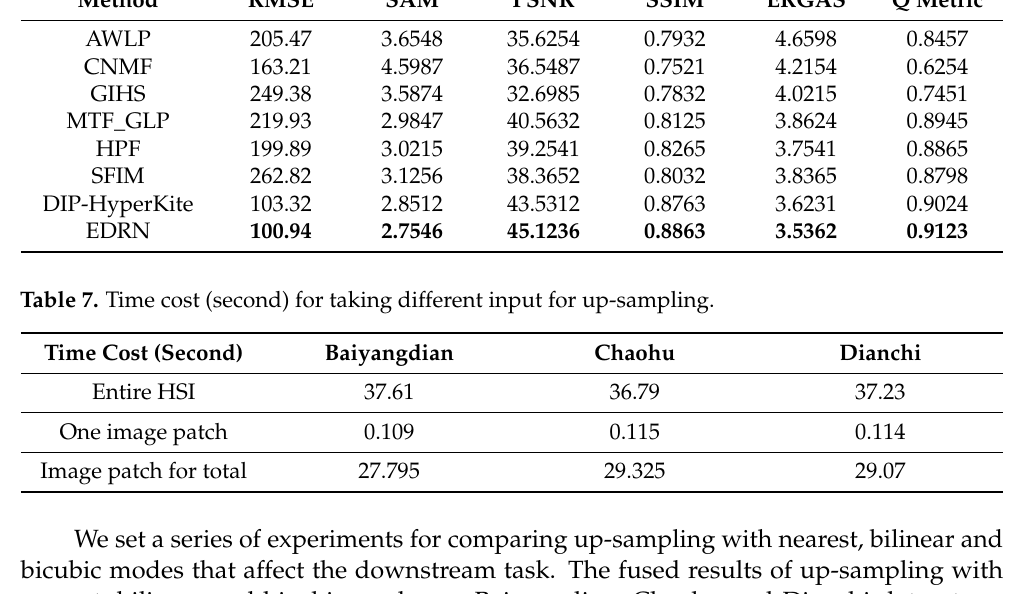
Table 6. Quality of the compared and proposed fusion methods for the Chikusei dataset for RMSE, SAM, PSNR, SSIM, ERGAS and the Q metric. Method RMSE SAM PSNR SSIM ERGAS Q Metric AWLP 205.47 3.6548 35.6254 0.7932 4.6598 0.8457 CNMF 163.21